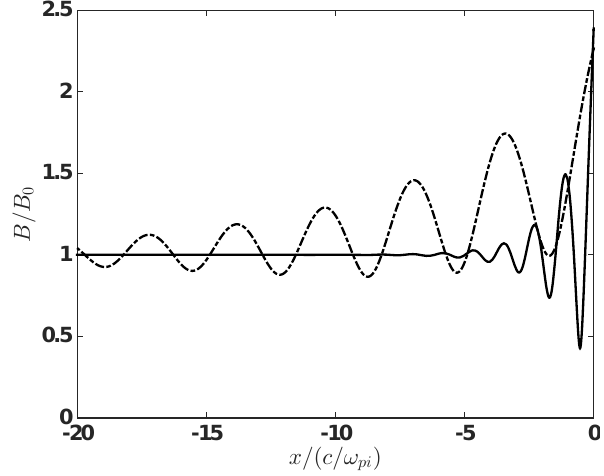
Figure 3. Comparison of the profiles for θ = 70 ◦ (solid line) and θ = 30 ◦ (dash-dotted line). Here the coordinate is measured in ion inertial